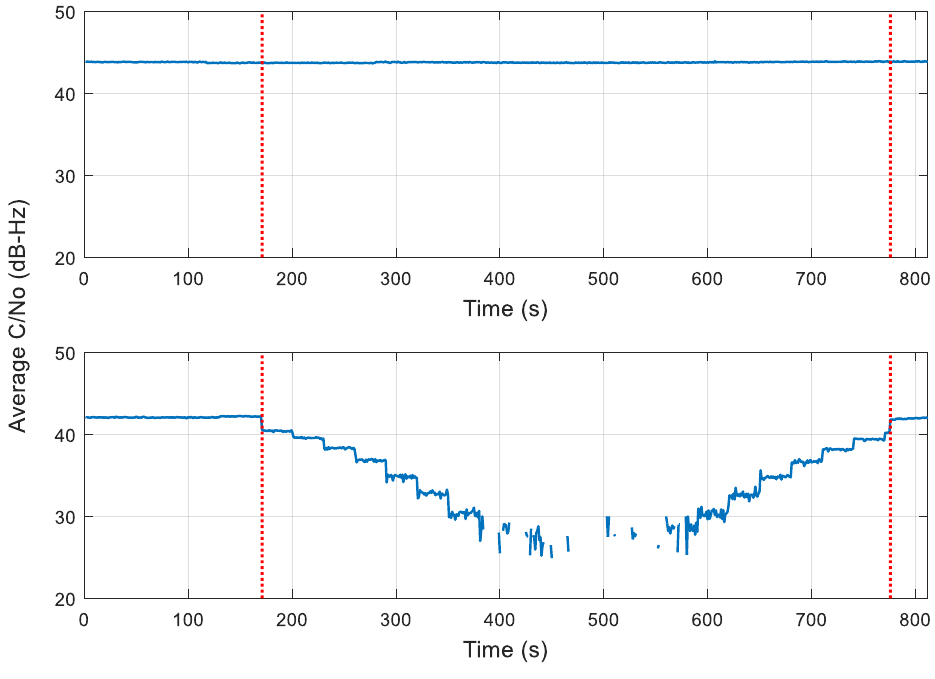
Figure 14. Average carrier-to-noise ratio of scenario #6. ( Top figure )—GPS measurements; ( bottom figure )—GLONASS measurements.